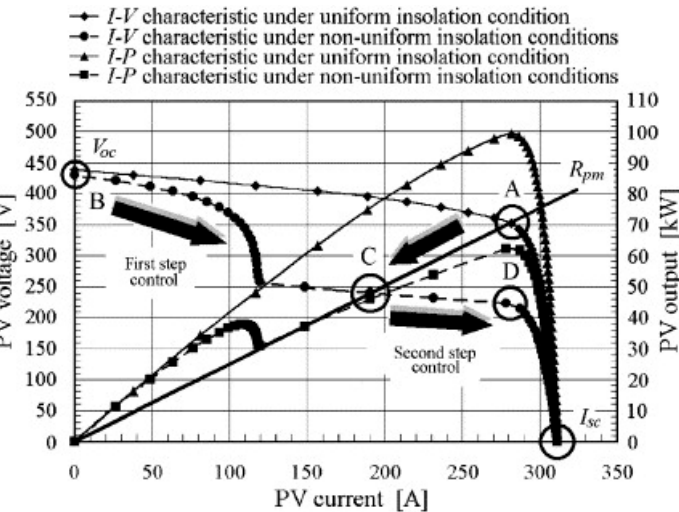
Figure 10. PV array characteristic curves under non-uniform solar irradiance conditions with a two- stage MPPT control method [44].